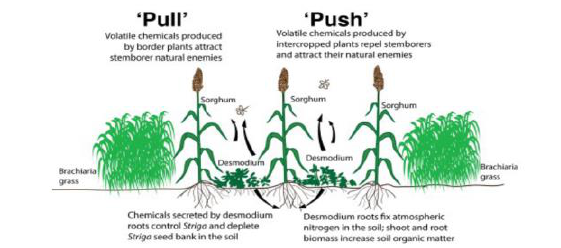
Figure 6: Push-pull technology to control FAW (Khan et al.,